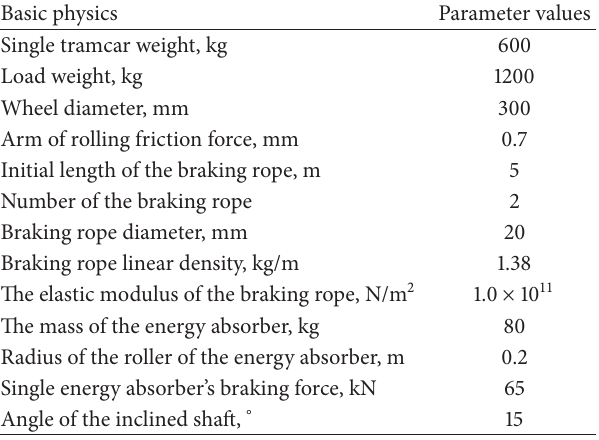
Table 1: The technical parameters of the tramcar and energy